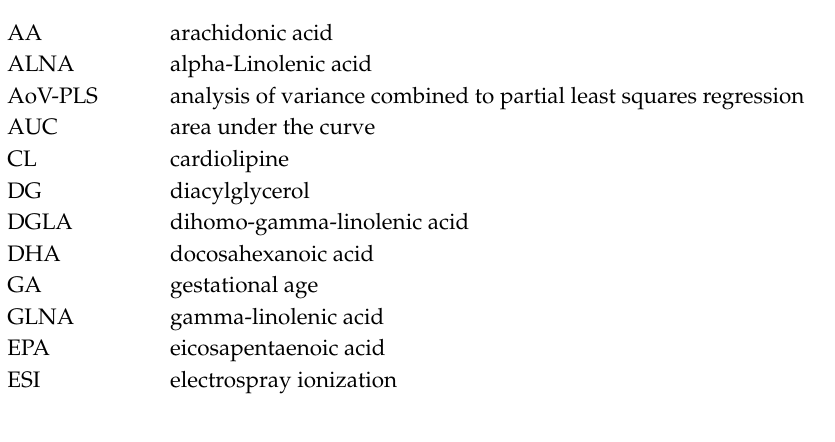
Figure S1: Multi-group PLS-DA score plots based on the LC-ESI − -HRMS profiles obtained on human preterm milk; Figure S2: AoV-PLS and LDA models, based on the LC-ESI − -HRMS profiles of human preterm milk, on the factor weight Z -score (discharge-birth); Table S1: Concentration levels of total fatty acids expressed as % of total identified FA, measured in human preterm milk at W2, W3, W4 of lactation and provided to newborns with “faster” or “slower” growth; Table S2: Abundance (10 6 ) of annotated discriminant lipids measured in breast milk at week 2 (W2), W3, W4 of lactation provided to preterm infants with fast or slow